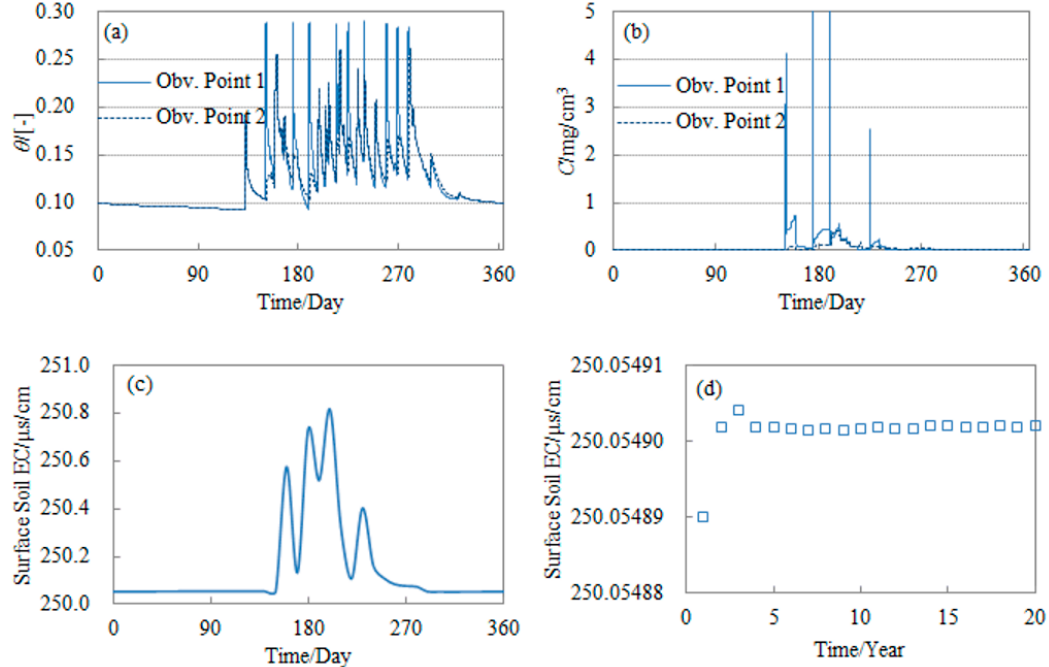
Figure 8. Annual and interannual changes in water and salt in shallow-buried drip irrigation. ( a ) Water content at observation point; ( b ) concentration of soil solution at observation point; ( c ) annual variation in topsoil salinity; ( d ): interannual variation in topsoil